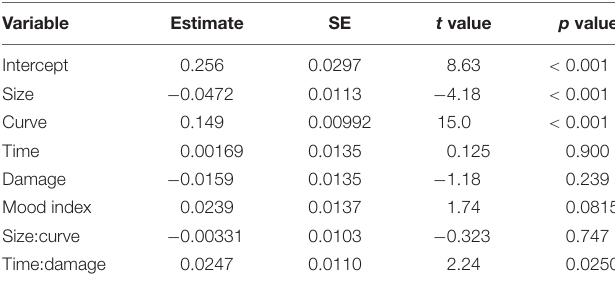
TABLE 4 | Effects of reward positivity (RewP)